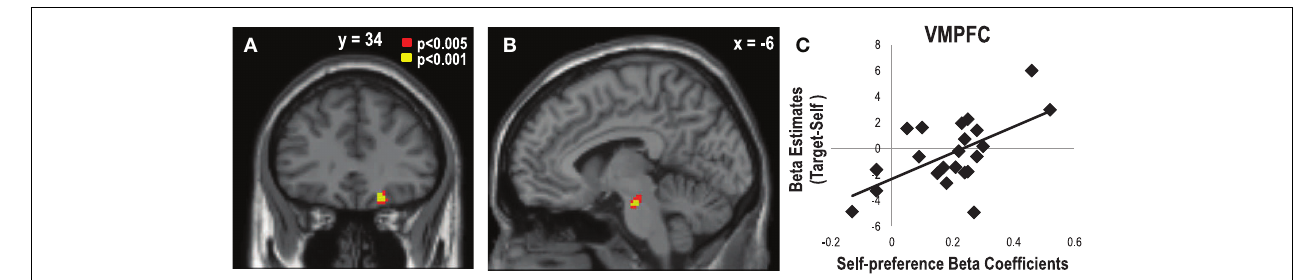
FIGURE 5 | Ventromedial Prefrontal Cortex (VMPFC) and Ventral Tegmental Area (VTA) activity associated with the impact of self-preference on the estimated target preference. (A) The VMPFC ( x = 20, y = 34, z = − 16, Z = 3.77, corrected, p < 0.05) and (B) the VTA ( x = − 6, y = − 18, z = − 22, Z = 3.76, corrected, p = 0 . 06) activities during